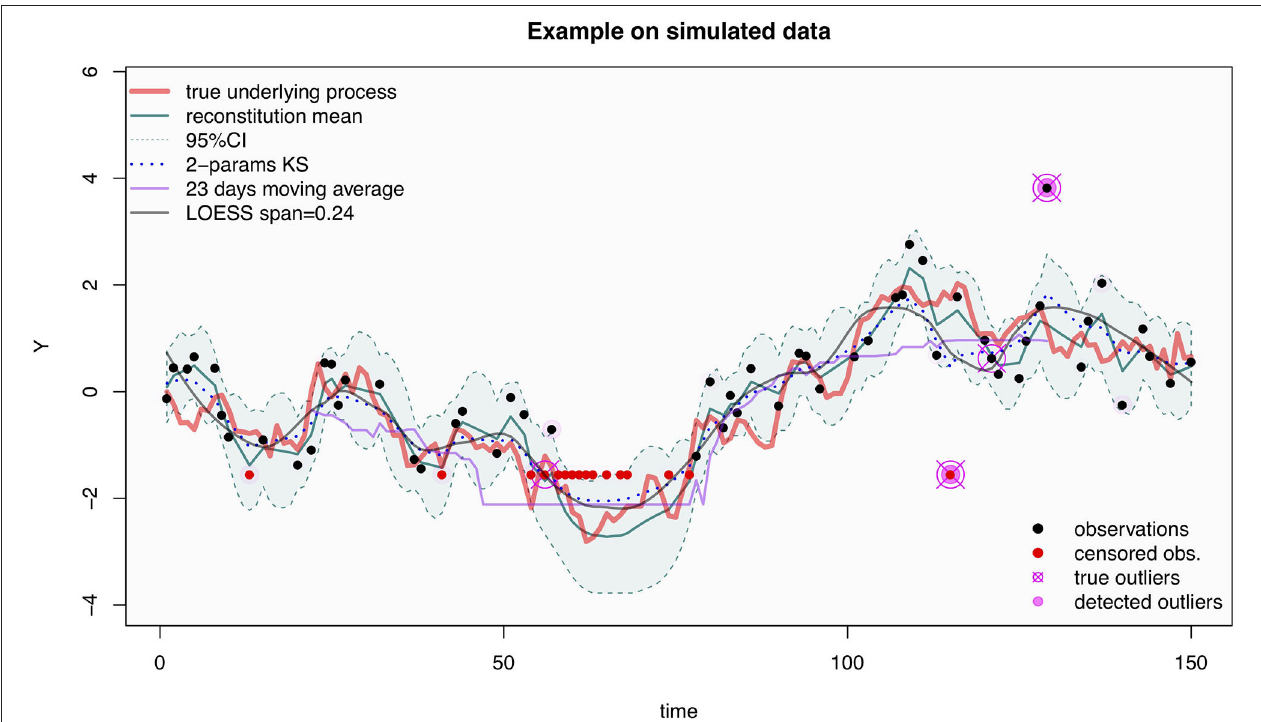
FIGURE 3 | Simulated data with 16 % of censored data and p = 7 % of outliers and results from the proposed (smoothing, outlier detection, and prediction) method, the equivalent 2-parameter Kalman Smoother, the 23-days moving average smoother, and the LOESS with 0.24 as span parameter.